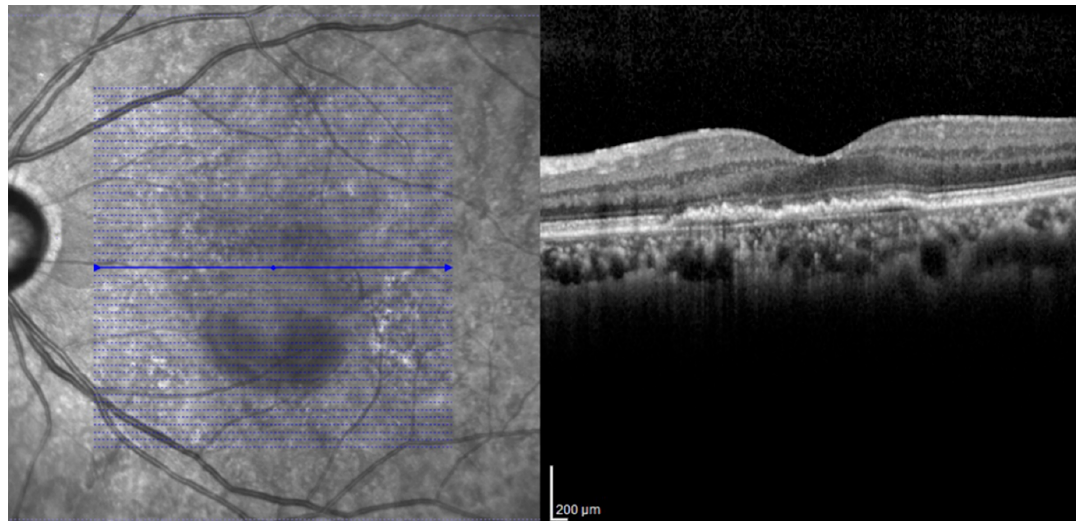
Figure 1. The volumetric scans of Spectralis SD-OCT. A custom 20° × 20° volume acquisition protocol which covered a 6 mm × 6 mm surface of the macula was used. With this protocol, 49 cross-sectional B-scan images were obtained, each composed of 512 A-scans.